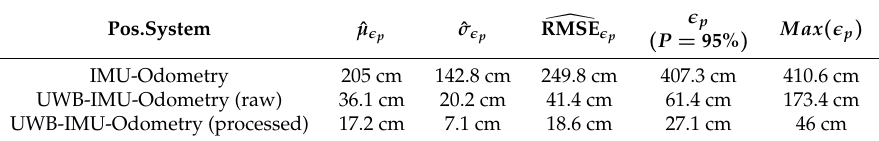
Table 3. Statistical analysis of the positioning distance error (cid:101) p